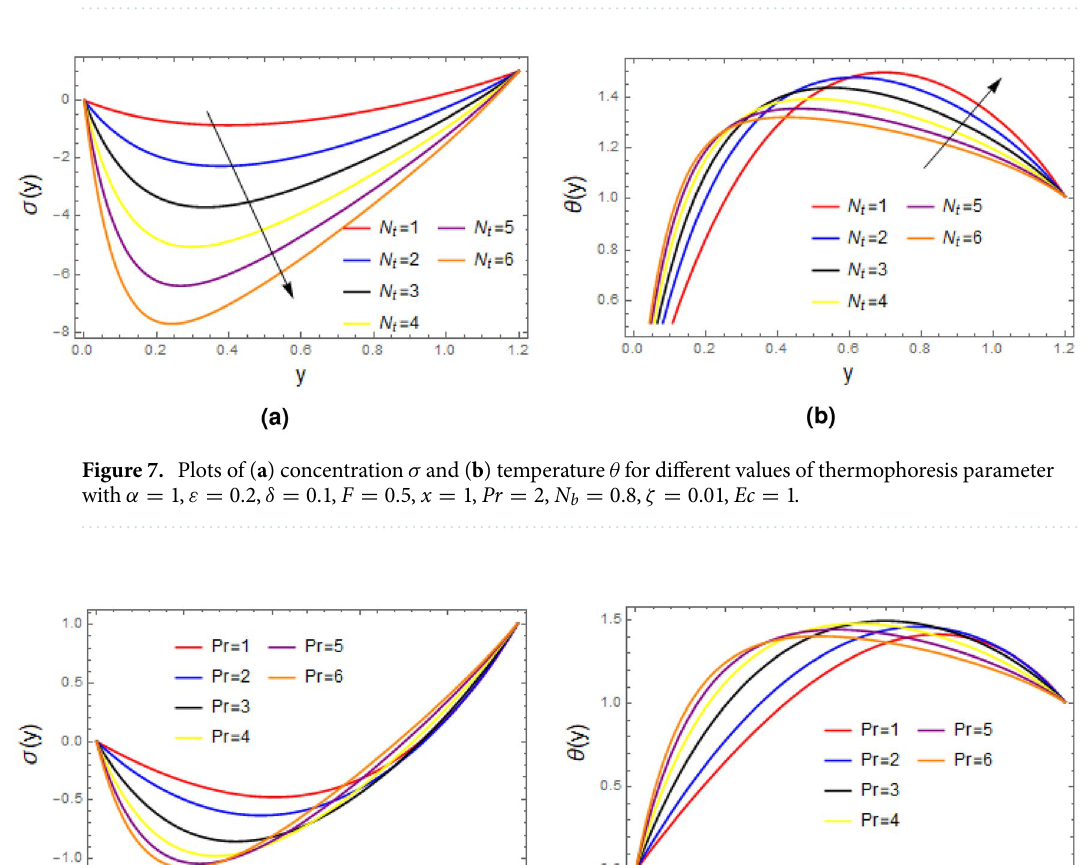
Figure 6. Plots of ( a ) concentration σ and ( b ) temperature θ for variations of relaxation time, with α = 1 , ε = 0.2 , δ = 0.1 , F = 0.5 , x = 1 , Pr = 2 , N b = 0.8 , N t = 1 , Ec = 1 .